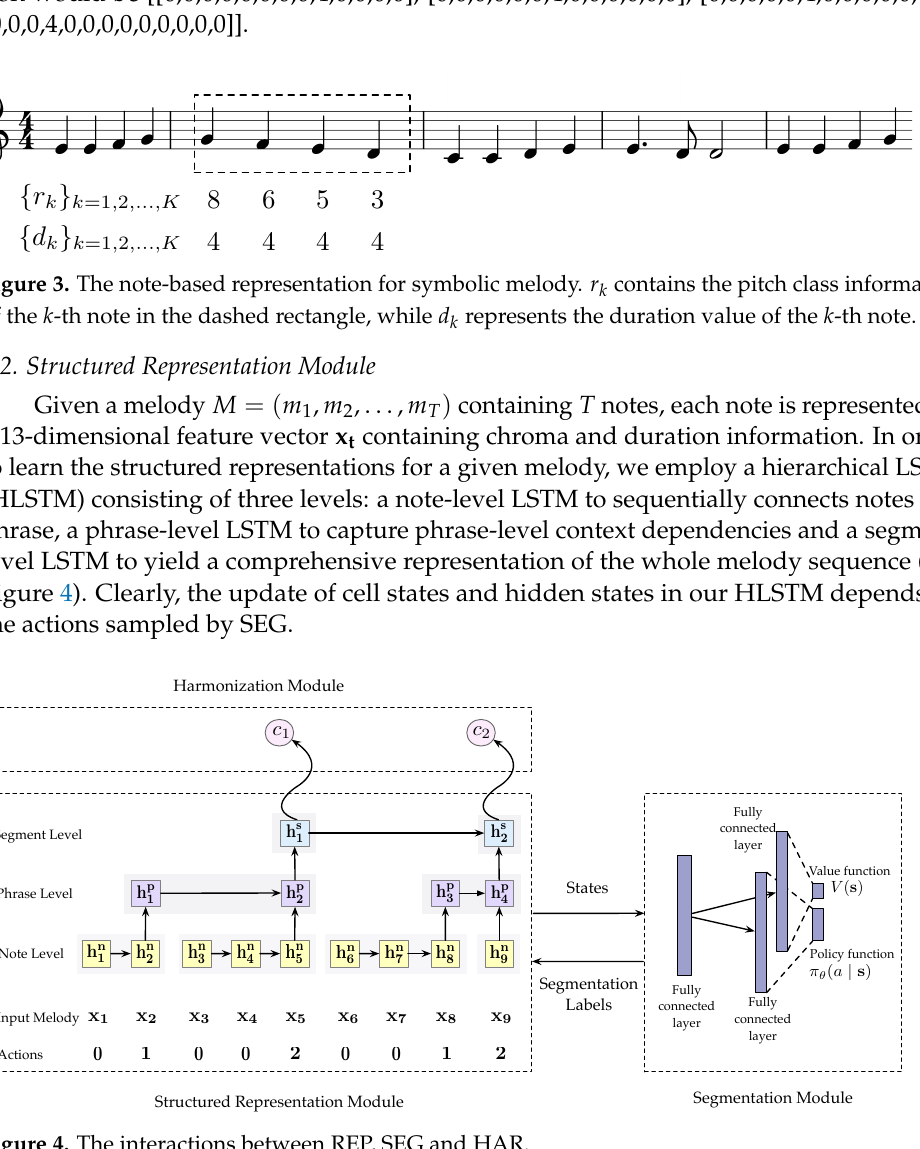
Figure 4. The interactions between REP, SEG and